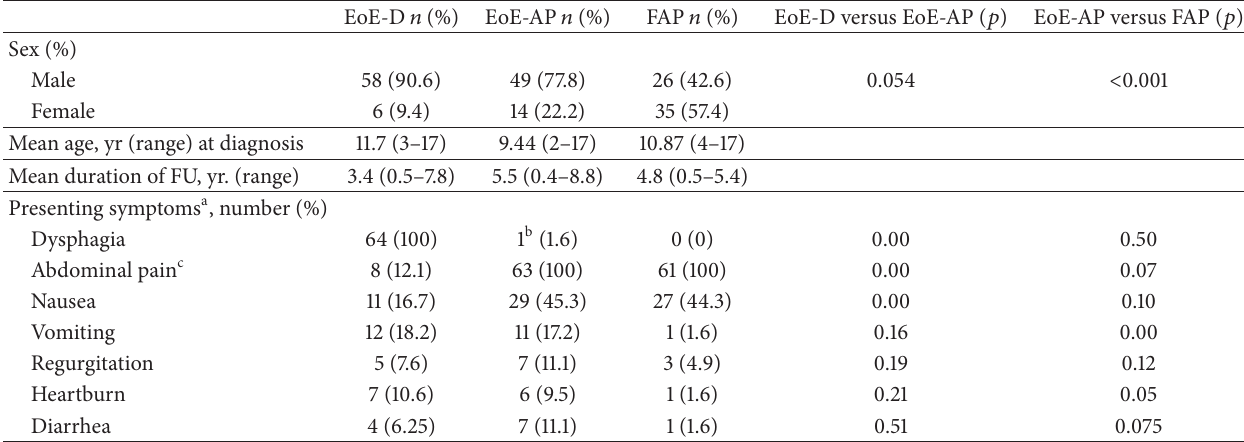
Table 1: Clinical features of patients with eosinophilic esophagitis and functional abdominal